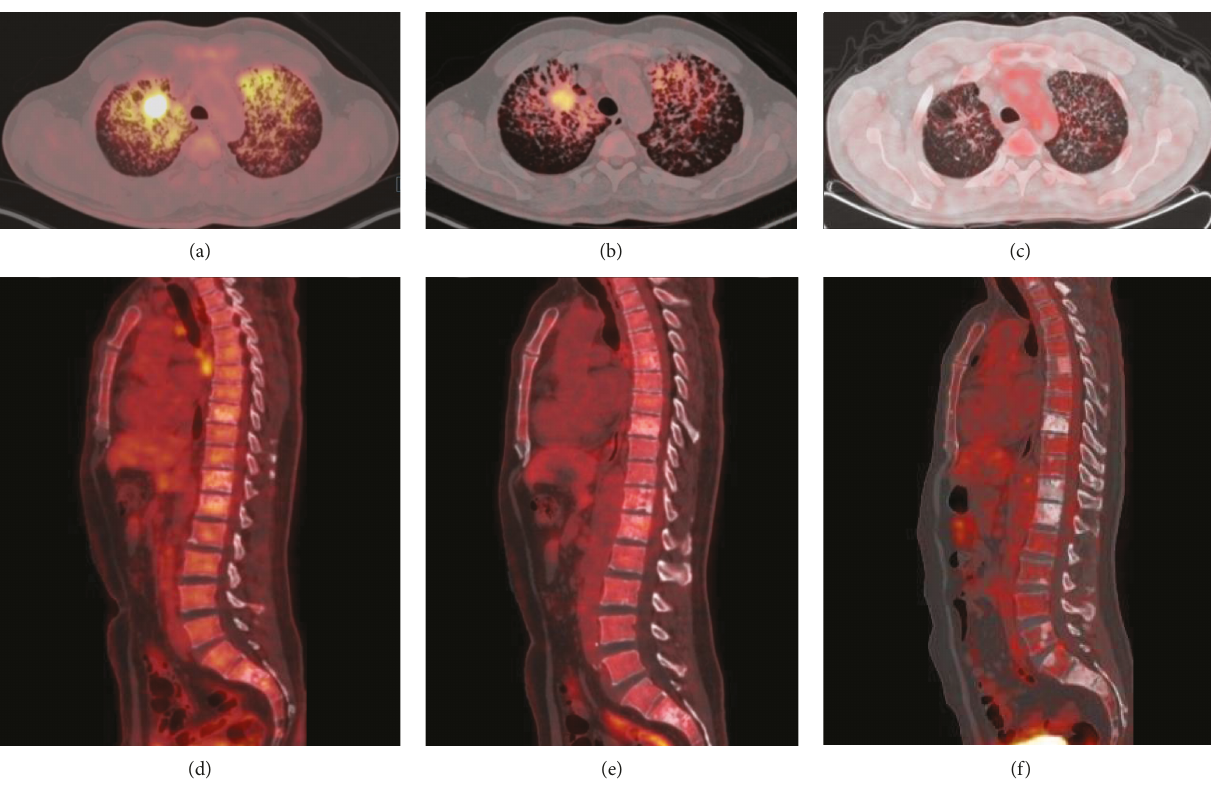
Figure 2: 18-FDG PET CT fusion images: axial and sagittal slices. (a, d) Right upper lobe mass with abnormally increased metabolism with surrounding lymphangitic carcinomatosis on both upper lobes with increased metabolic activity as well. On sagittal slices, multiple mixed type (blastic/lytic) metastatic lesions a ff ecting axial skeleton. (b, e) Images obtained 7 months later showed marked decrease on metabolic activity on both pulmonary and skeletal lesions. (c, f) Images obtained 11 months from fi rst study demonstrate the absence of metabolic activity on both primary site and spinal